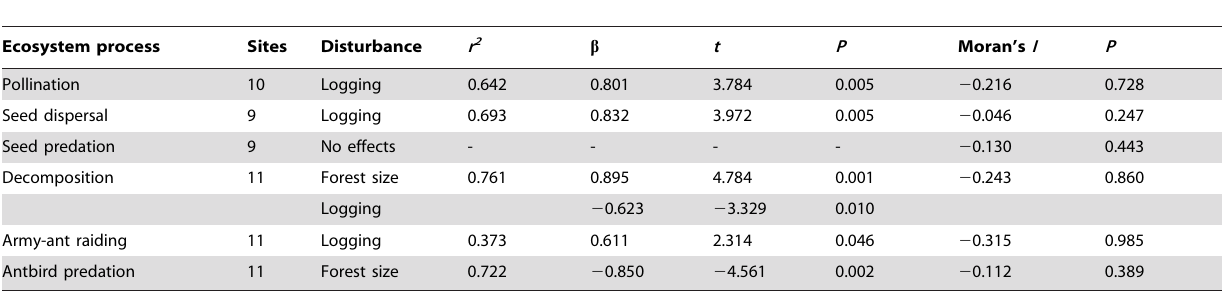
Table 1. Effects of forest size and selective logging on six ecosystem processes in Kakamega Forest, Kenya.